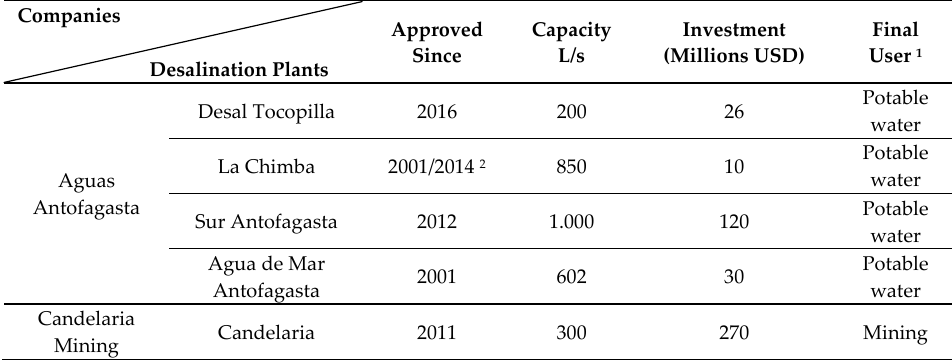
Table 1. Companies operating desalination plants under study.